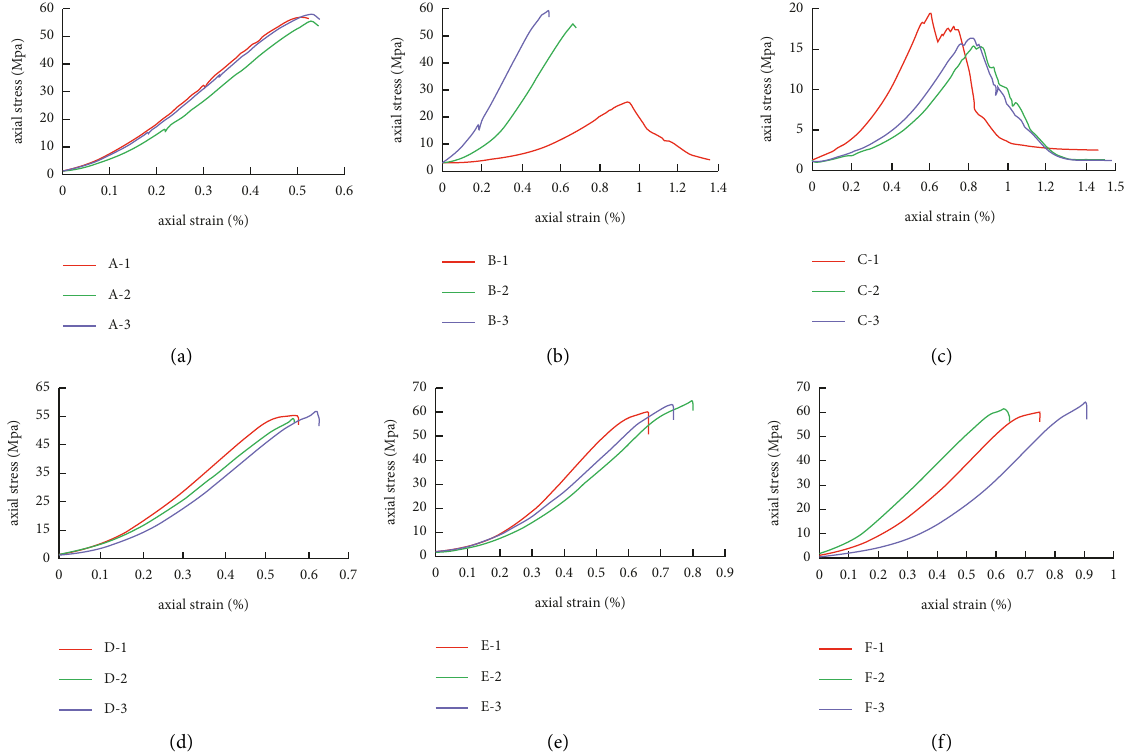
Figure 13: Axial stress-strain curve. (a) Group A specimens. (b) Group B specimens. (c) Group C specimens. (d) Group D specimens. (e) Group E specimens. (f) Group F